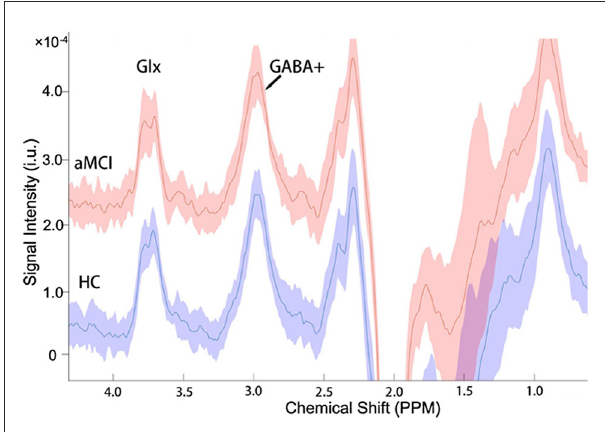
FIGURE3 The mean ( ± standard deviation) GABA + and Glx edited spectra acquired by the MEGA-PRESS sequence in the healthy controls (HCs) and patients with aMCI. The signal intensities of the aMCI group consistently plus a constant of 2.0 × 10 − 4 for more convenient signal display and